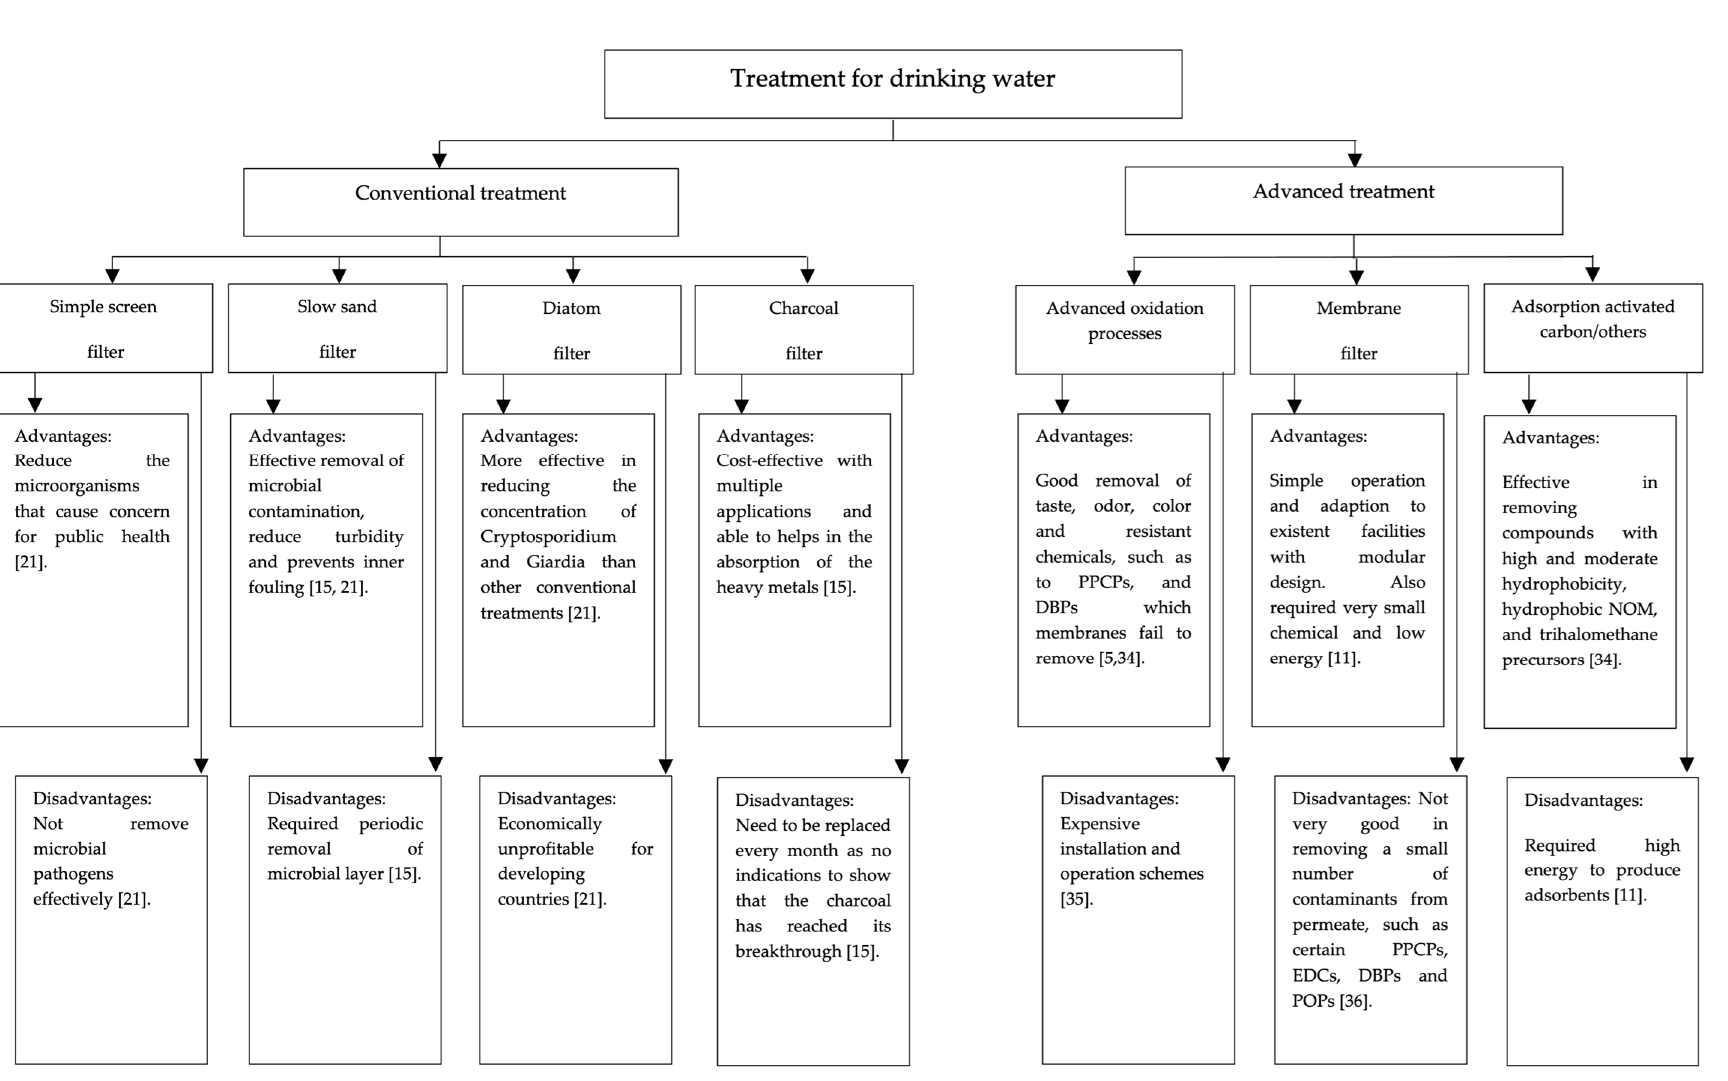
Figure 1. Available treatment for drinking water [5,11,15,21,34–36]